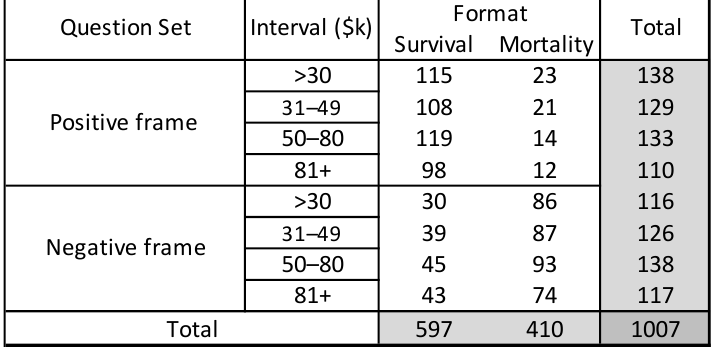
Figure 6: Respondent Total by Income